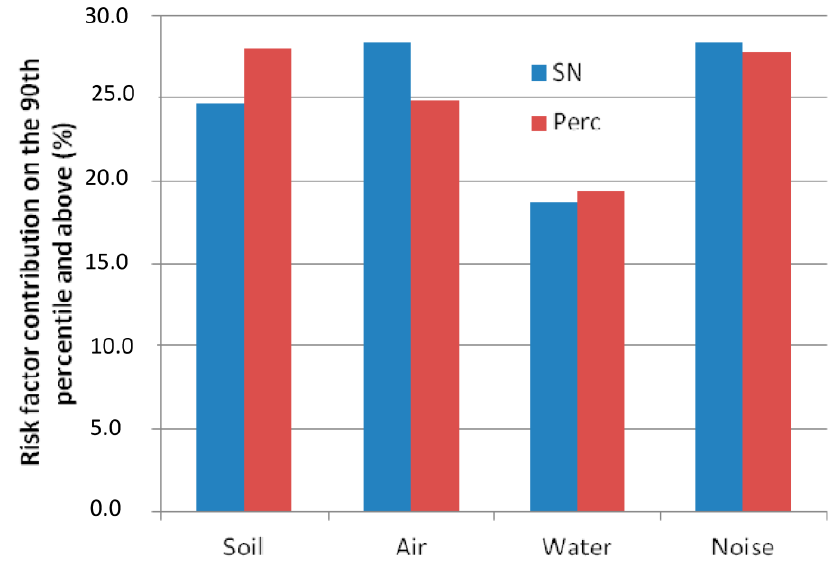
Figure 5. Histograms of the percentage contribution of the risk factor to the composite indicator above the 90th percentile for the normal transformation (SN = blue) and percentile rank method (Perc = red).